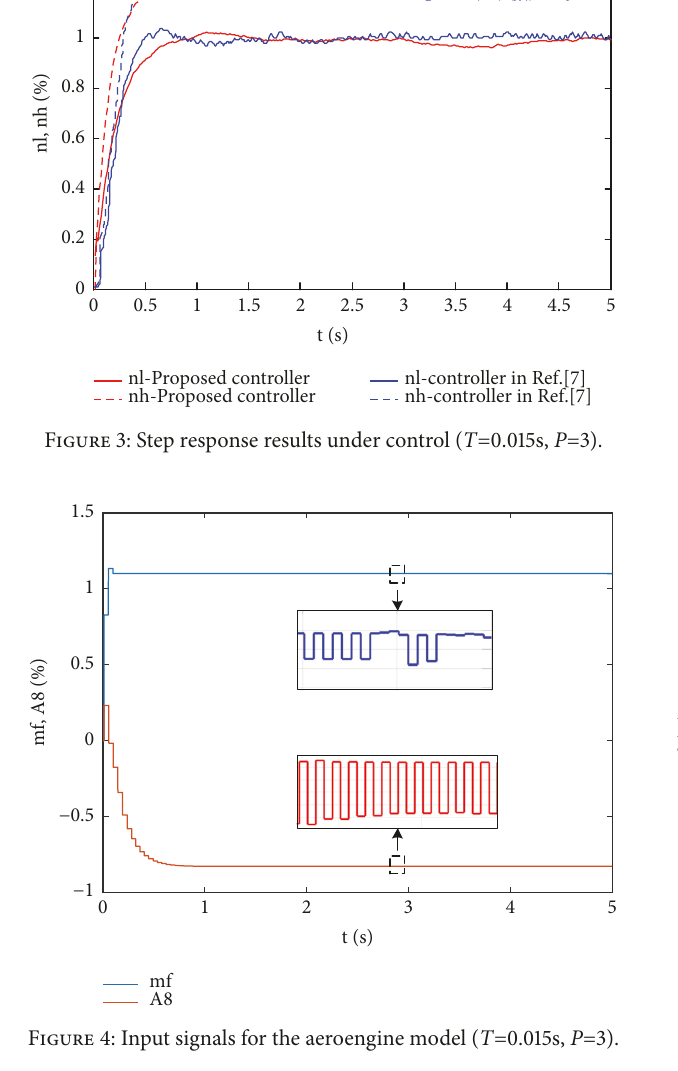
strength. Under the conditions of 70% and 90% bandwidth